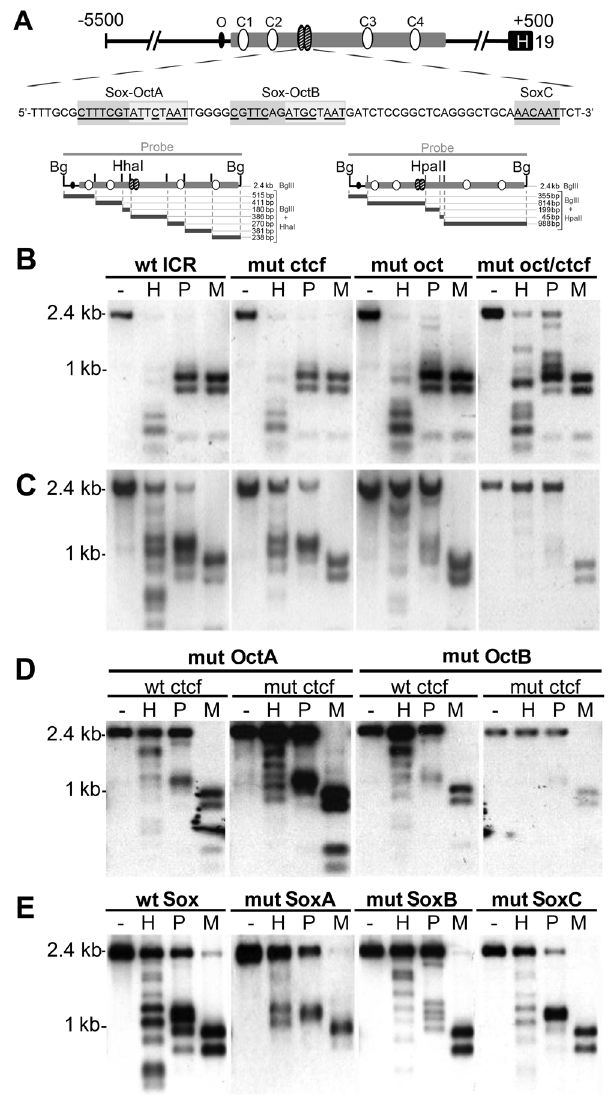
Figure 1. Analysis of ICR transgene methylation in F9 cells. ( A ) Top: Structure of mouse ICR transgene depicting consensus octamer, O (black oval); four CTCF sites, C1–C4 (white ovals); two Sox-Oct motifs (striped oval).Middle: ICR sequence encompassing both Sox-Oct motifs (A and B) and a downstream Sox site (SoxC). Nucleotides matching the respective consensus sequences are underlined. Bottom: Hha I, and Hpa II restriction maps for the 2.4 kb Bgl II,(Bg) ICR fragment. ( B–E ) Southern blot analysis of F9 genomic DNA prepared from polyclonal populations with stably incorporated WT or mutant ICR transgenes. DNA was digested with Bgl II followed by digestion with Hha I (H), Hpa II (P), or Msp I (M). The 2.4kb Bgl II fragment was used as a probe. The endogenous ICR is visible only as a faint signal compared to that generated by the multicopy transgene. Each blot is representative of the data obtained from three independent polyclonal populations. ( B ) Stable transfectants obtained from unmethy- lated ICR constructs containing either a WT sequence, (wt ICR); mutations in all four CTCF sites, (mut ctcf); mutation in the three octamer sites, (mut oct); or in all octamer and CTCF sites (mut oct/ctcf). (C–E) All plasmids were in vitro methylated at Hha I and Hpa II sites prior to transfection. ( C ) Stable transfectants obtained from the same WTand mutant constructs as in (B) but with in vitro methylation ( D ) Stable transfectants obtained from methylated constructs with OctA or OctB mutations combined with either WT or mutant CTCF sites. ( E ) Stable transfectants obtained from methylated constructs with separate mutations in SoxA, SoxB or SoxC. Both the mutant and WT (wt sox) constructs contain two modified Spe I cloning sites flanking the respective Sox-Oct elements. See Table S1 for WT and mutant